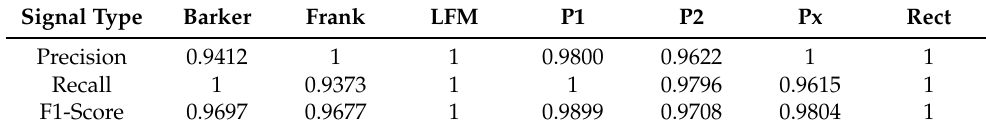
Table 7. Classification report of the model with AWT applied (Precision, Recall, and F1-Score). Signal